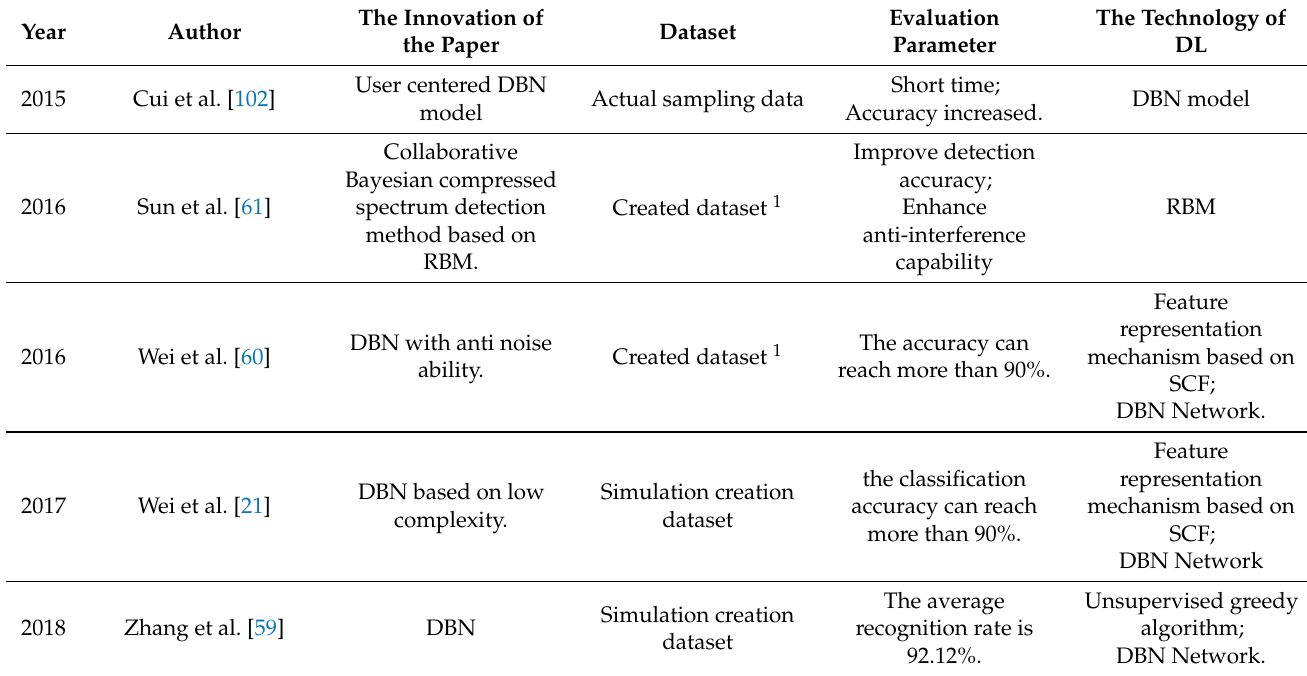
Table 4. Radio modulation recognition networks based on